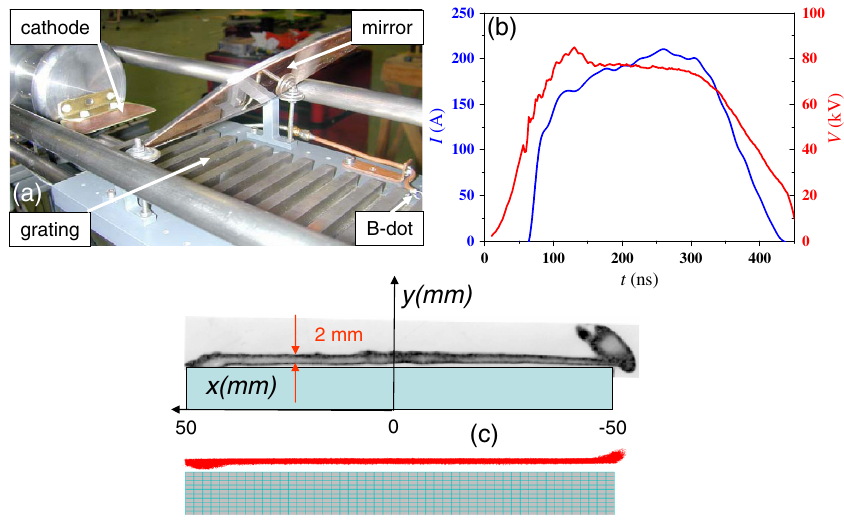
FIG. 1. (Color) (a) Photograph of the setup. (b) Typical voltage and current pulse forms. (c) Imprint of beam on thermosensitive paper at beam stop. Also is shown a MAGIC 3D simulation of section of beam at